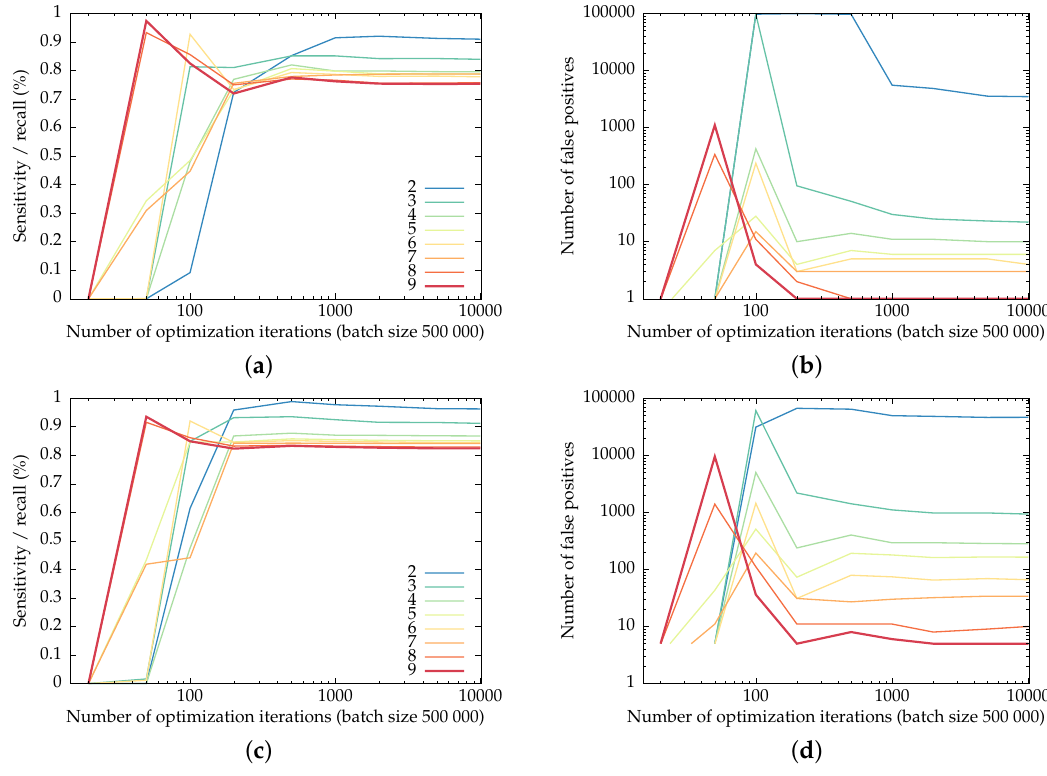
Figure 10. Recall of the checkerboard corners (the fraction of corners detected as such) and the number of false positives in the uEye and GoPro datasets for networks with varying spatial support radii, as a function of the training iterations. ( a ) and ( b ): recall and false positives for the uEye dataset, ( c ) and ( d ): recall and false positives for the GoPro